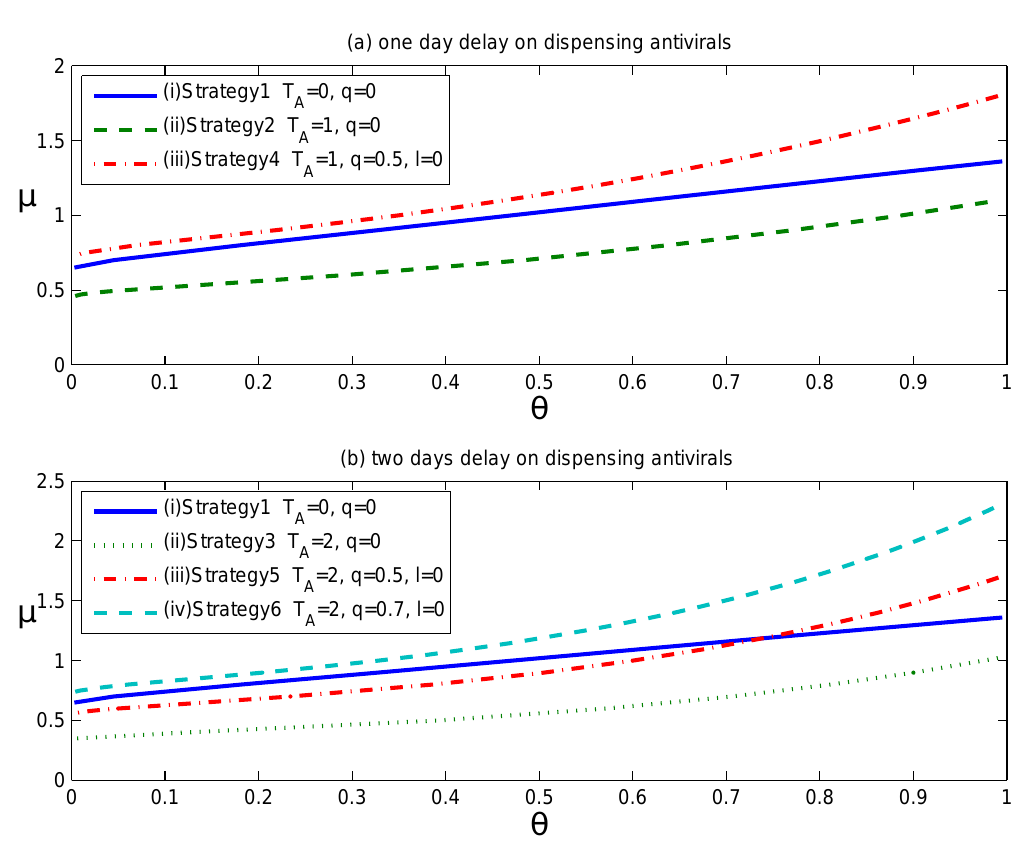
Figure 1. The effects of antiviral prophylaxis and voluntary self-isolation are displayed in two scenarios: ( a ) one day delay on dispensing antiviral drugs; ( b ) two days delay on dispensing antiviral